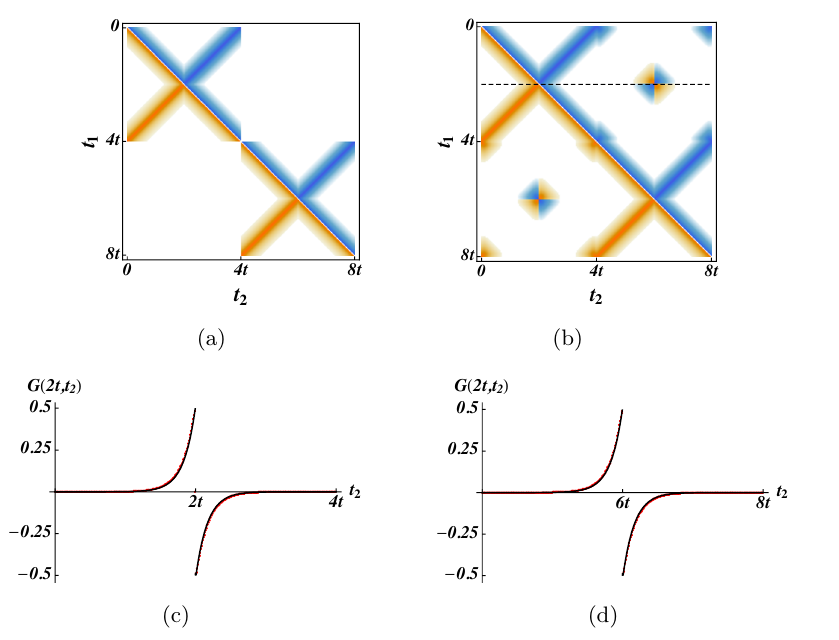
Figure 7 . The replica diagonal solution G 2 (a) and replica non-diagonal solution G 1 (b) of Schwinger-Dyson equation for the second R(cid:19)enyi entropy. (c,d) Comparison between numerical solutions and analytic solutions located on the dashed line in (b). (d) The nonvanishing correlation sourced by the twist operator is also given by the pro(cid:12)le of e (cid:0) ( J + V ) j t j =q at the dashed line in (b) due to the boundary condition at t 1 = 2 t . We choose the parameter J T = 20, V = J = 0 : 2, q = 4. Note that T = 2 t . The number of discretization is M =